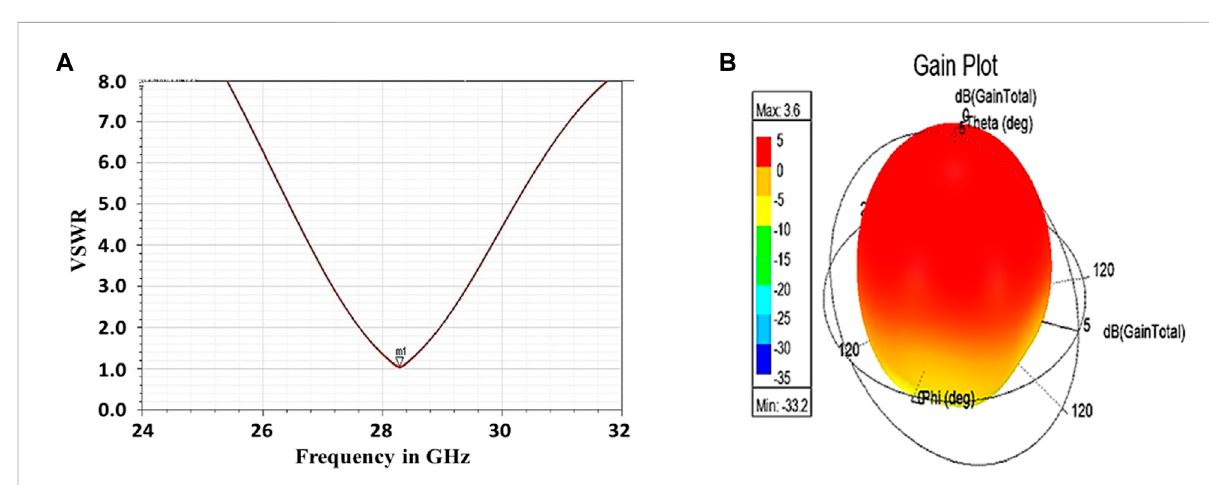
FIGURE 12 (A) Simulated VSWRofarectangularmicrostrippatchantennaonphotoniccrystal and (B) 3-Dplotoffar- fi eldgainattheresonantfrequencyof 28.3